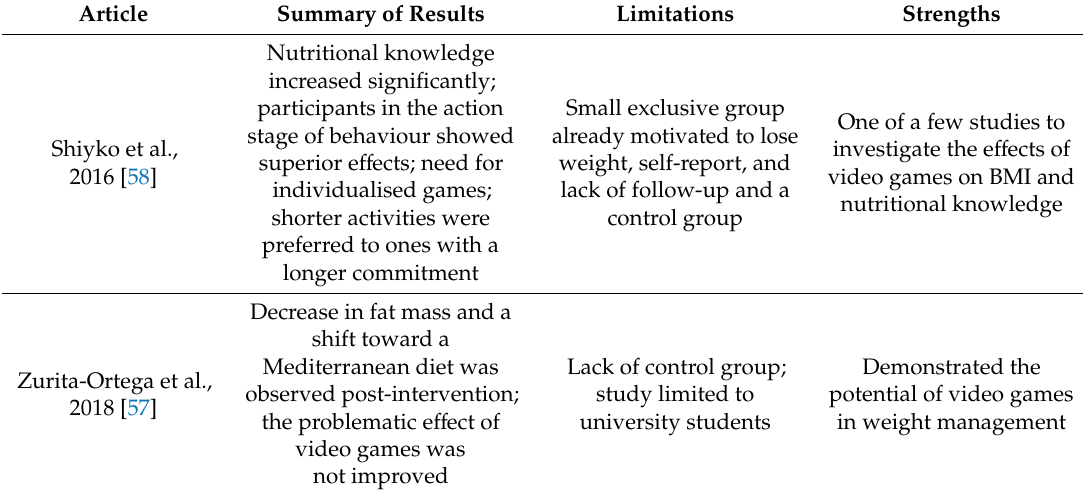
Table 4. Summary of results in studies using video games as a digital intervention for dietary behavior change. Summary of